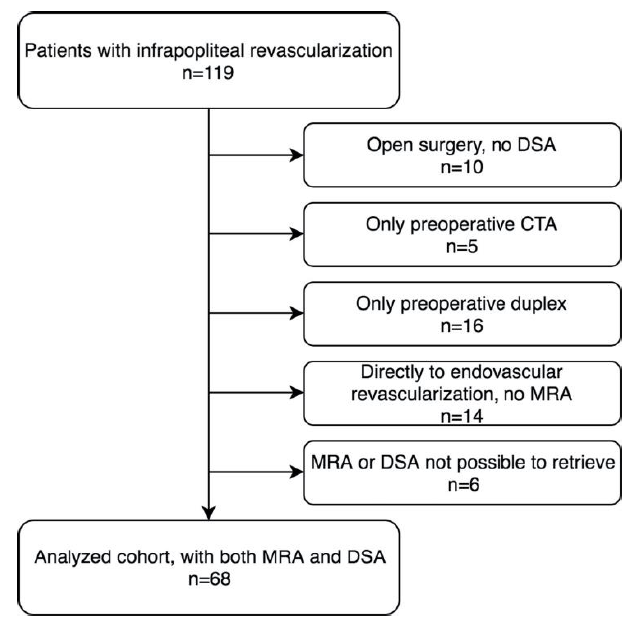
Figure 3. Flow chart showing the selection of the study cohort.